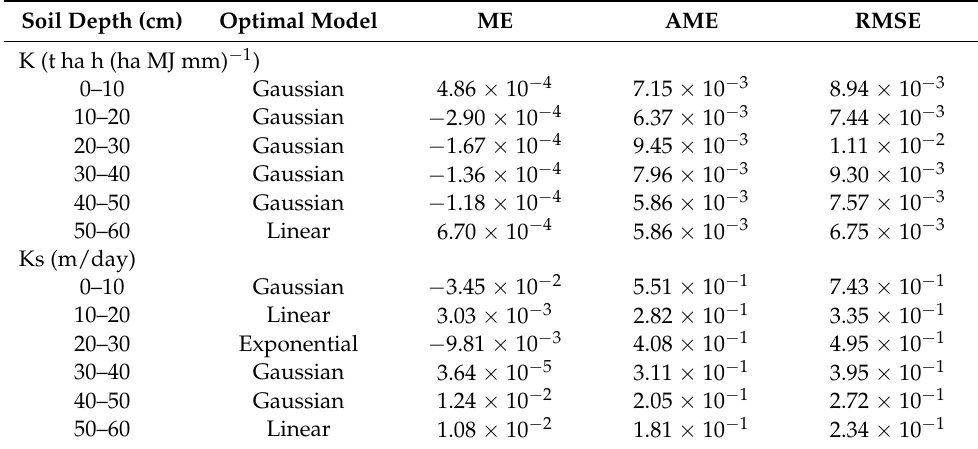
Table 3. Stability evaluation for different models of the ordinary kriging